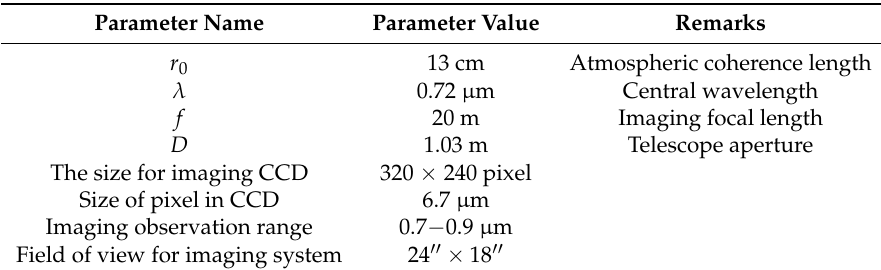
Table 1. The values of the main parameters for an AO imaging